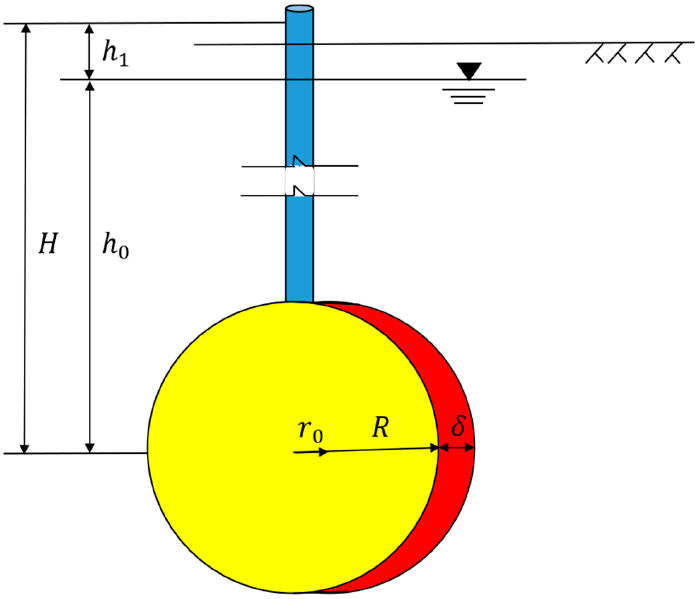
Figure 2. Slurry fracture diffusion model.